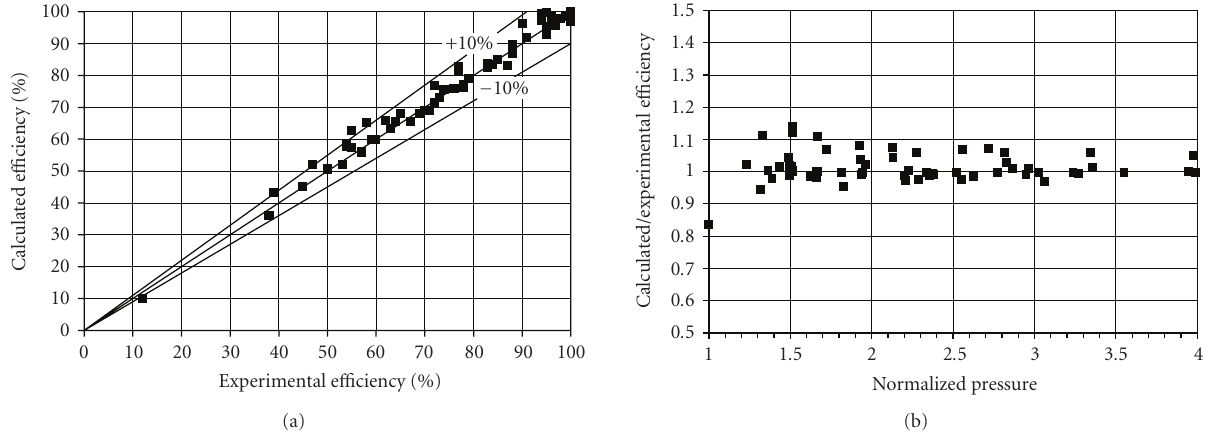
Figure 3: Performance of the adopted model in predicting condensation e ffi ciency as observed in PANTHERS-PCC tests.